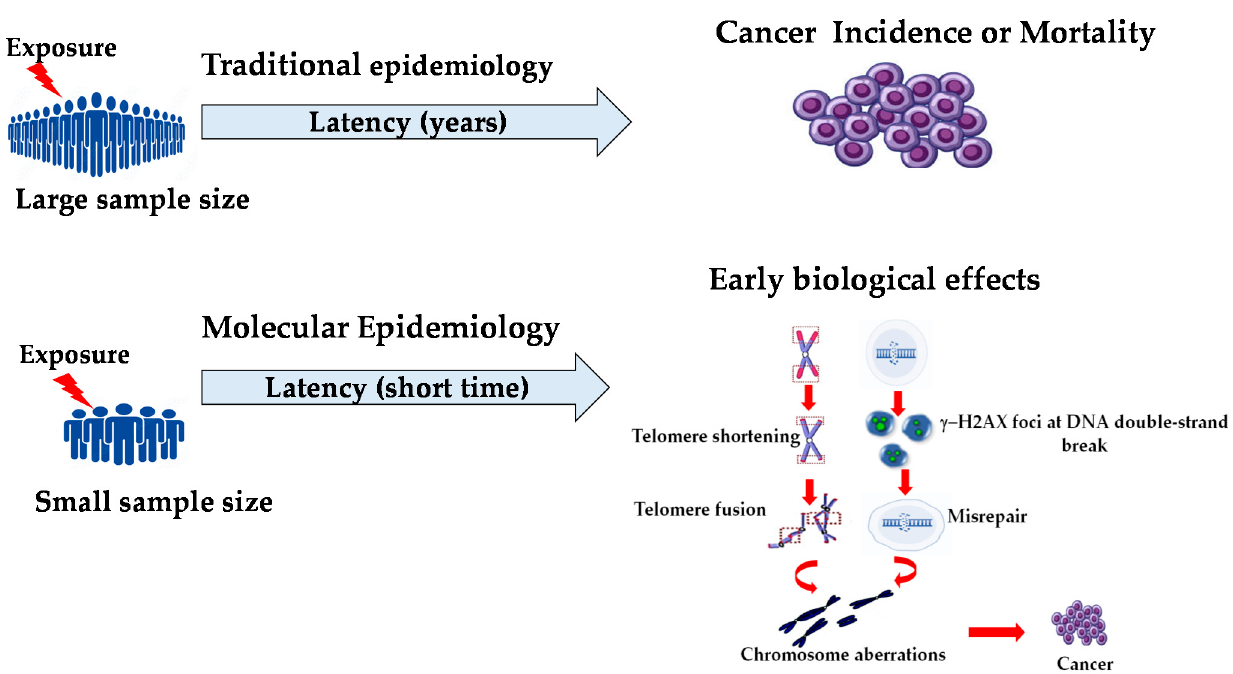
Figure 1. Molecular epidemiology may overcome some major limitations of traditional epidemiology and provide insights into disease causation. Validated biomarkers of effects can help to delineate the continuum of events between exposure and resulting cancer by identifying early changes in the natural history of cancer process.